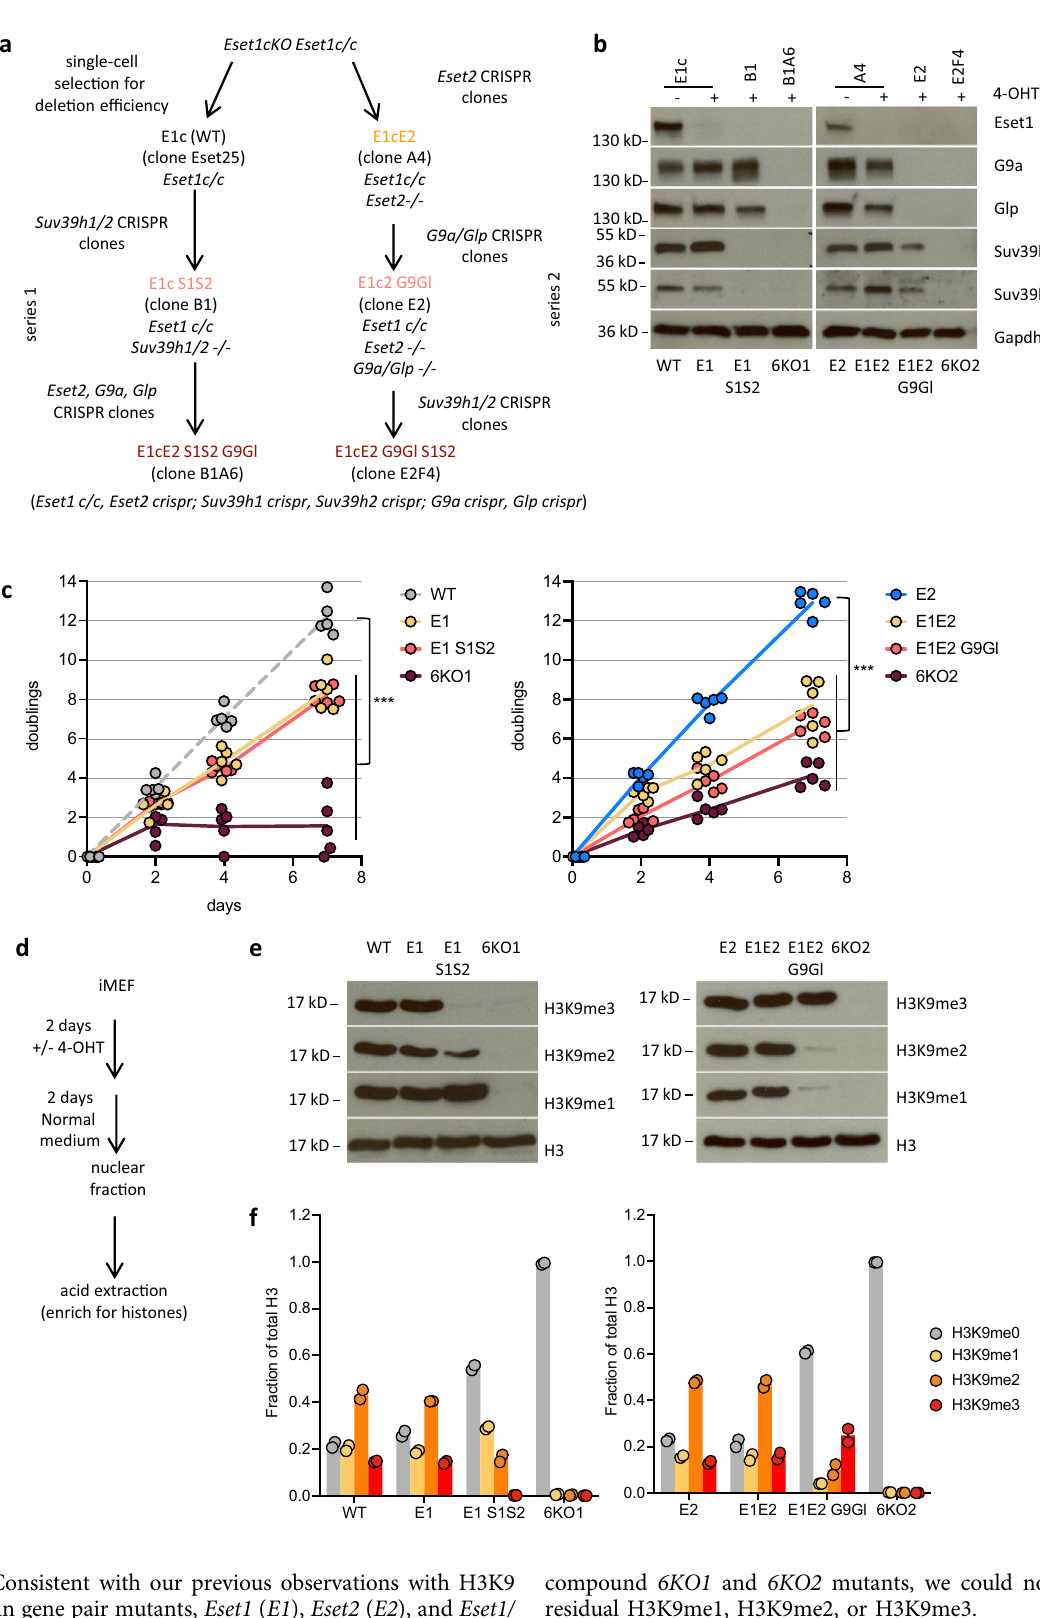
compound 6KO1 and 6KO2 mutants, we could not detect any residual H3K9me1, H3K9me2, or H3K9me3. To validate this observation with an antibody-independent approach, we analyzed the same extracts by mass spectrometry (Fig. 2f). We detected very similar changes in H3K9 methylation states, and con fi rmed the nearly total absence of H3K9 methylation in chromatin extracted from the 6KO1 and